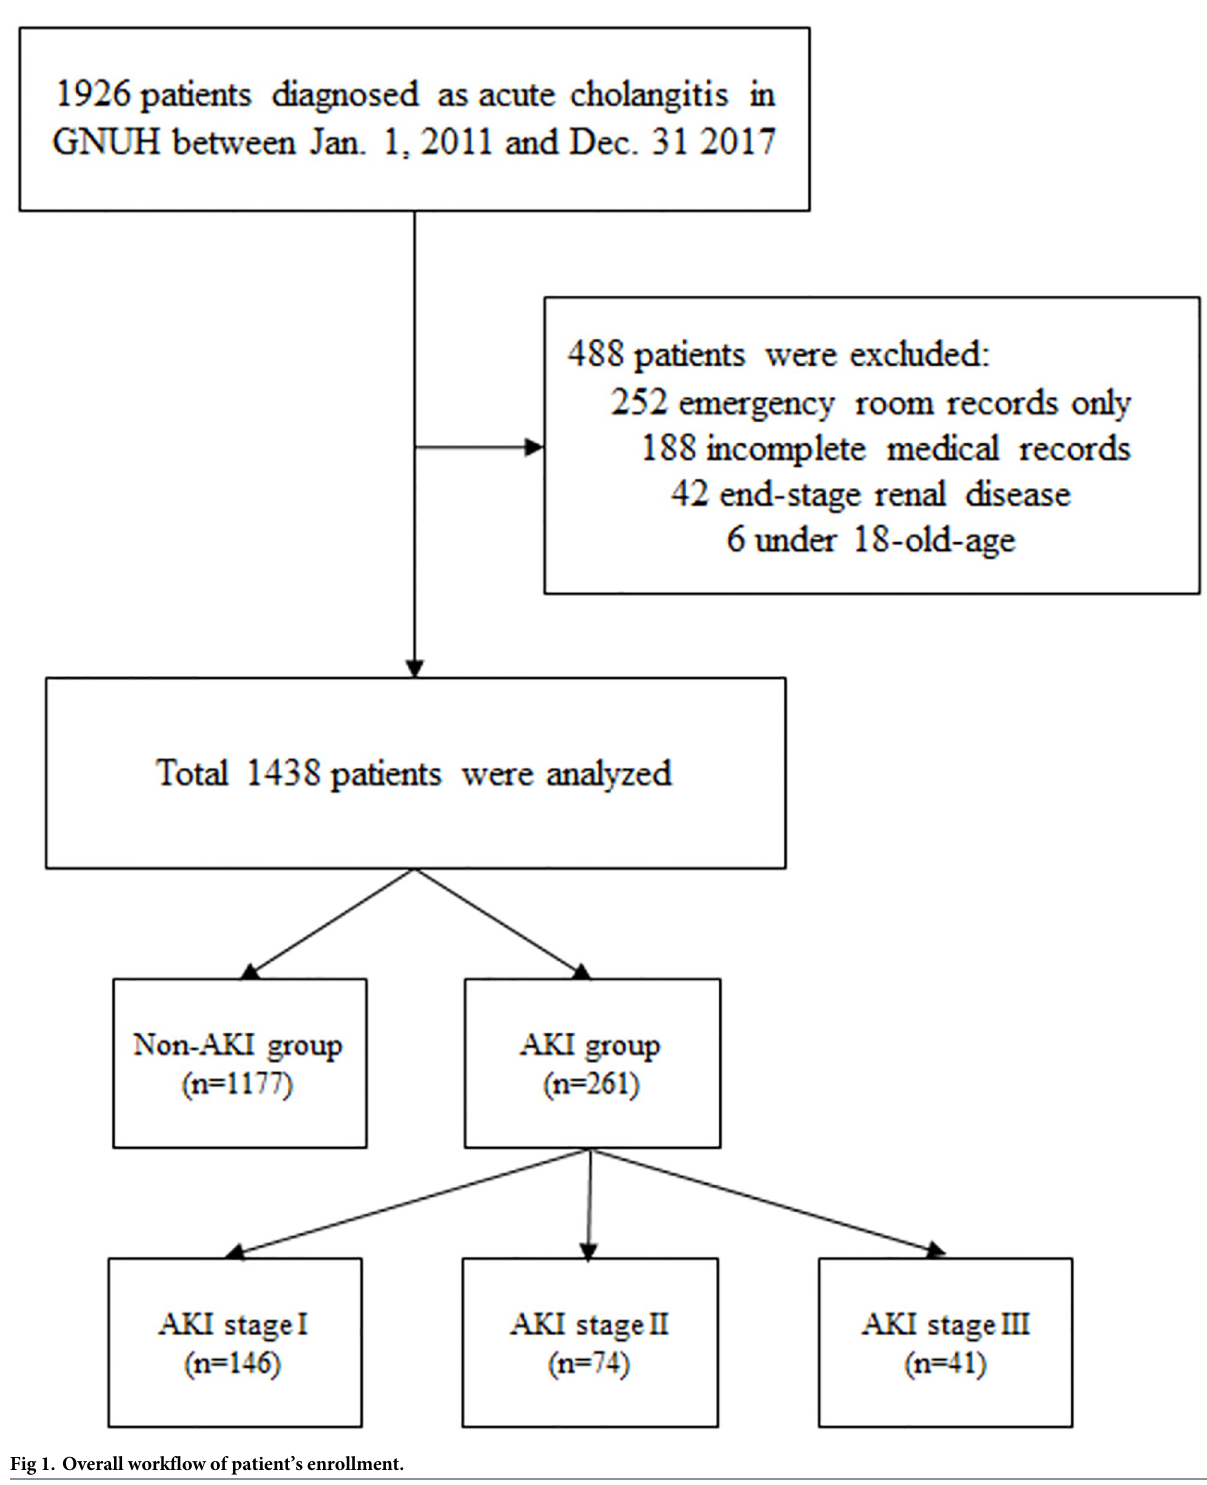
Fig 1. Overall workflow of patient’s